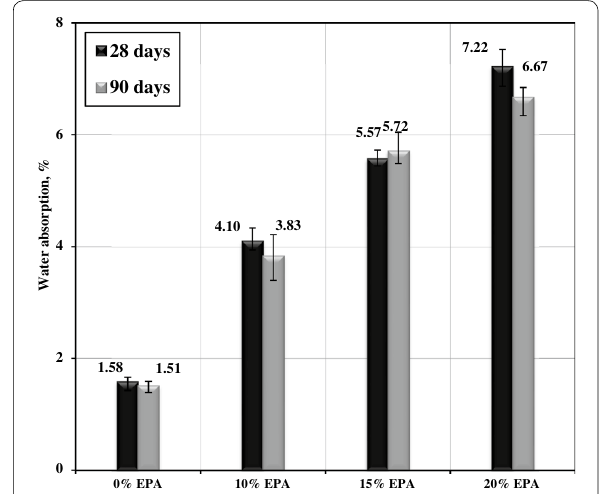
Fig. 9 Water absorption of concrete prepared with varying EPA